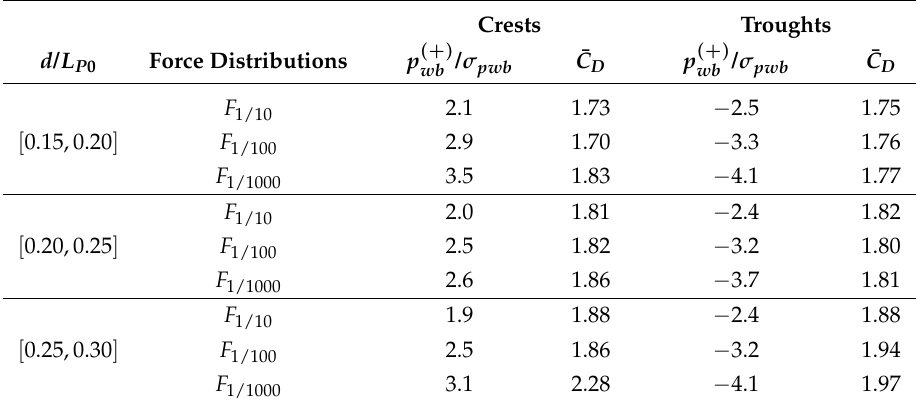
Table 3. Pressure distributions at the base of the U-OWC breakwater and mean values of the diffraction coefficient in front of the U-OWC corresponding to 1/10, 1/100 and 1/1000 force process in fixed intervals of d / L p 0 . Crests Troughts d / L P 0 Force